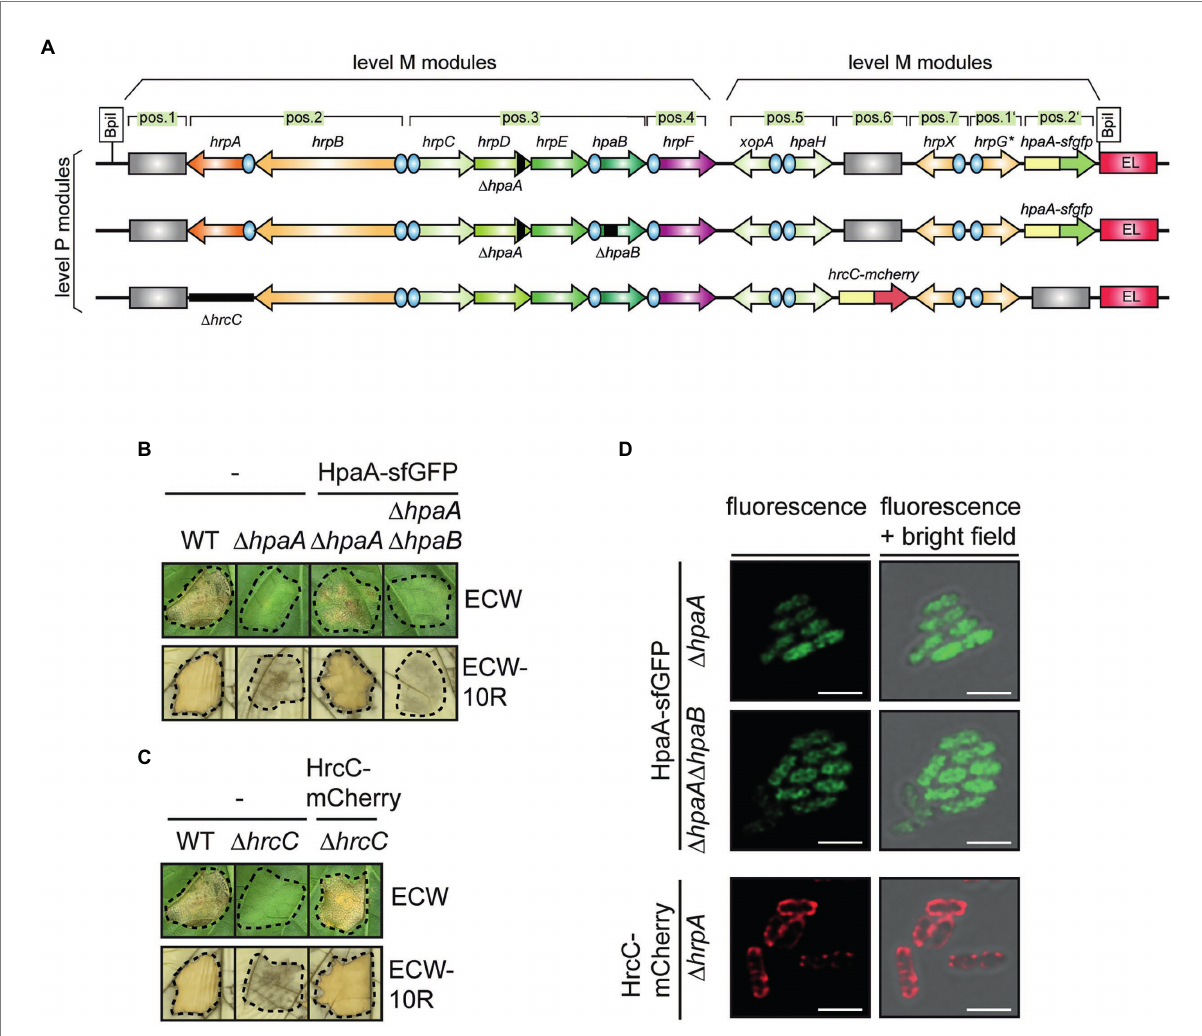
FIGURE 3 Localization studies with a HpaA-sfGFP fusion protein. (A) Schematic representation of modular T3S gene cluster constructs. Genes and operons are represented by arrows, promoters by blue circles. Grey rectangles represent dummy modules that were replaced by reporter fusions. Deletions are indicated with black rectangles. The names of single operons and genes is given above the arrows. The modular level P constructs resulted from the assembly of two level M modules. (B) Complementation studies with HpaA-sfGFP. Strain 85* ∆ hrp containing the wild-type modular T3S gene cluster (WT) or a derivative thereof with a deletion in hpaA ( ∆ hpaA ) and strain 85* ∆ hrp_fsHAGX containing modular T3S gene cluster constructs with deletions in hpaA or both hpaA and hpaB ( ∆ hpaAB ) and encoding HpaA-sfGFP in the flanking region of the T3S gene cluster as depicted